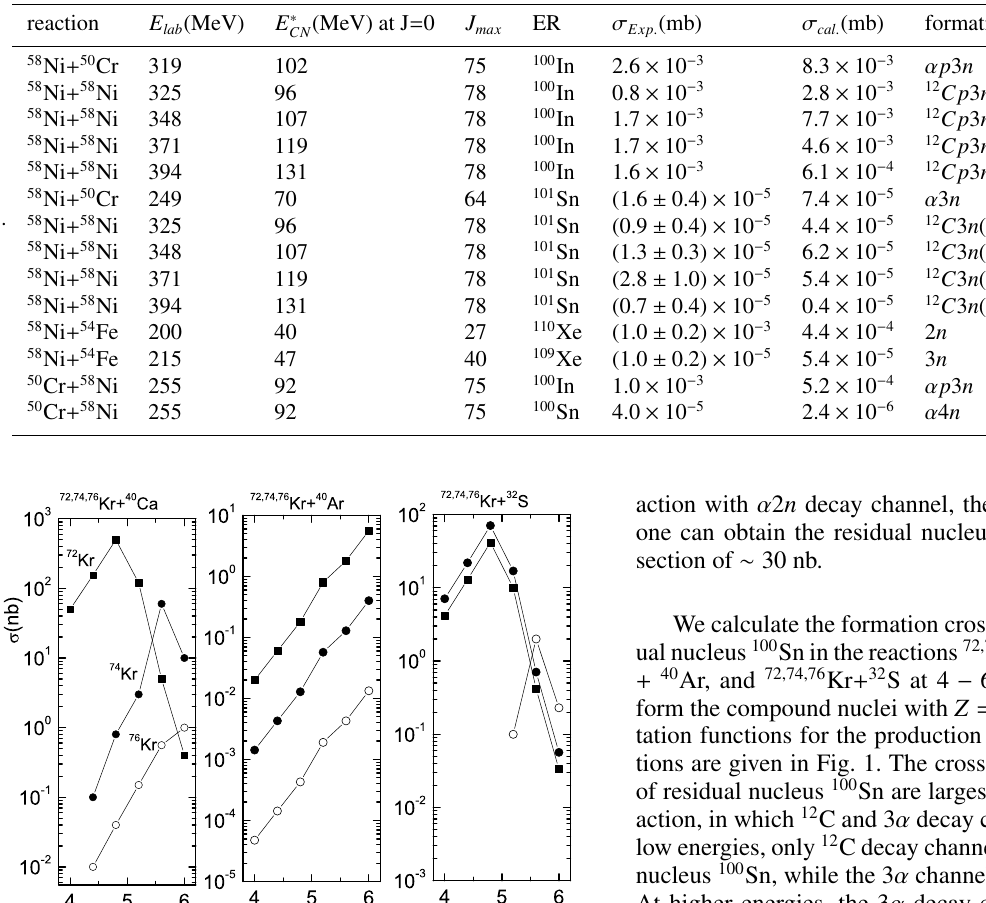
Table 1. Comparison of calculated production cross sections with the experimental data. The weights of main formation channels are derived from our calculations. Experimental values are taken from Refs. [1–3]